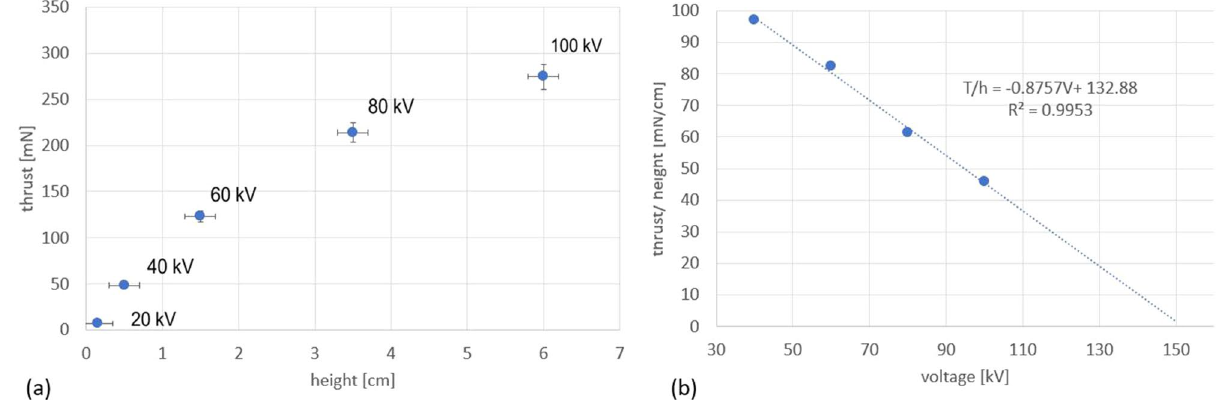
Figure 7. ( a ) Maximum RIE axial thrust dependance on the propeller axial height above the toroidal counter electrode at various voltages. Error bars are 3 mm height positioning error and 5% estimated measurement thrust error. ( b ) Variation of the axial thrust per cm height for a 20 kV increase in the applied voltage and positioning of the propeller above toroid at the optimal height (maximum thrust for the applied voltage).